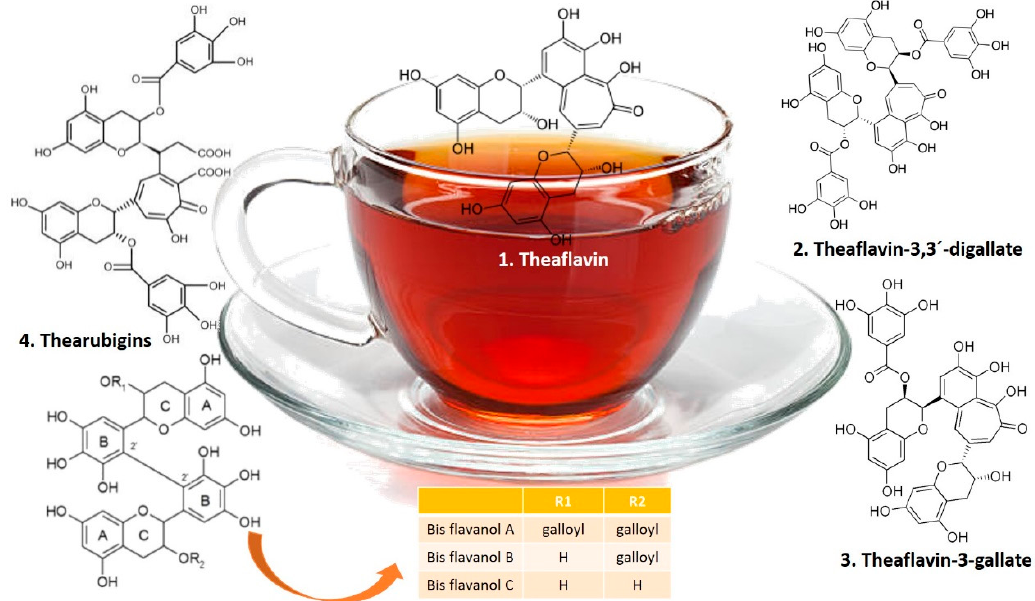
Figure 3. Chemical structures of theaflavins, thearubigins, and bis flavanols in black tea.